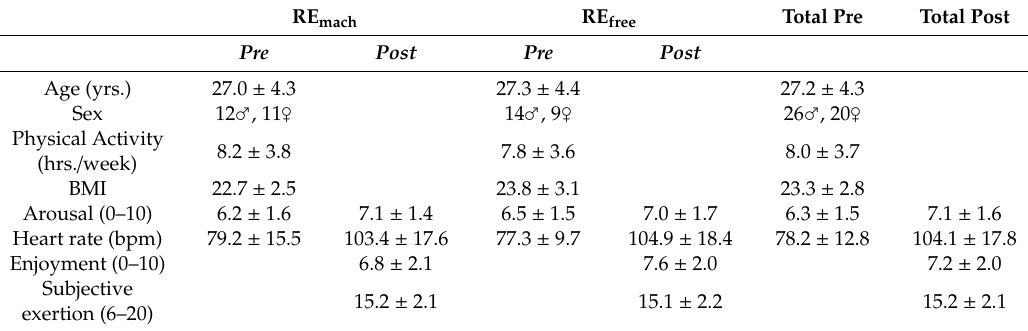
Table 1. Characteristics of the two groups measured pre- and post-intervention.